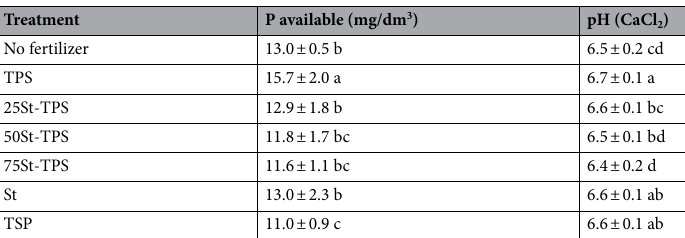
Table 1. Average available phosphorus (as phosphate) and pH of the sand at the end of the greenhouse experiment, at 42 days of maize cultivation. Indexes a, b, c, and d represent the statistical differences between treatments ( p < 0.05, n =